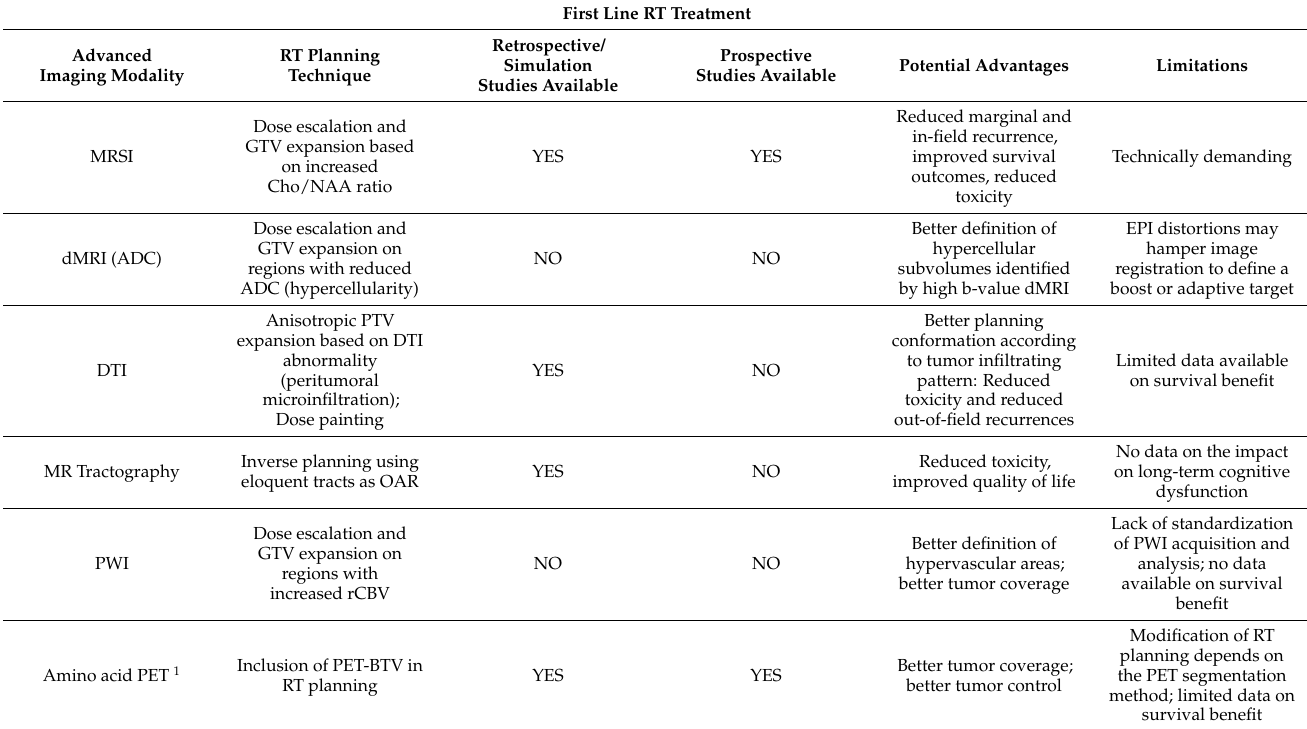
Table 1. Summary of findings on advanced imaging techniques for first-line RT planning of gliomas. First Line RT